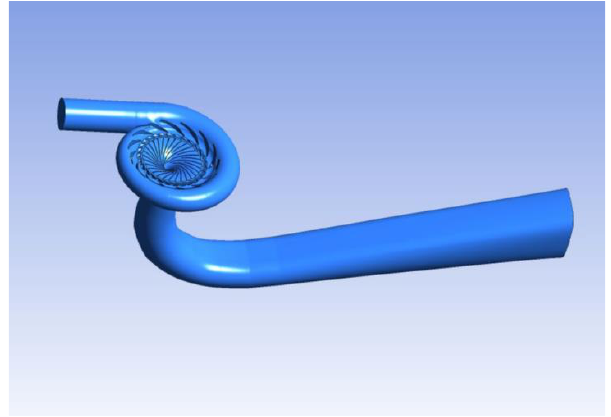
Figure 2. Calculation model of the Francis turbine.